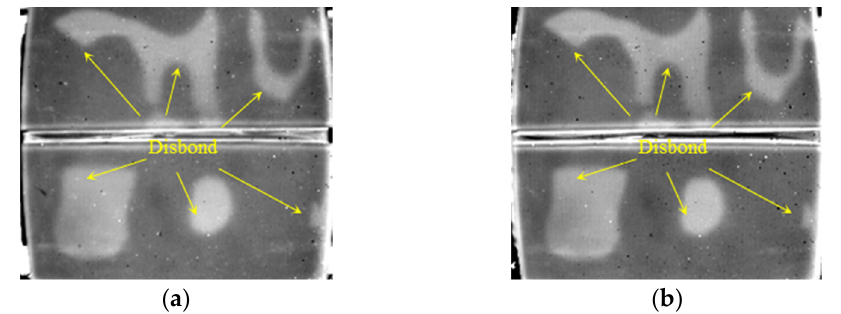
Figure 12. Detection results of disbond with 2 mm thick SIR. ( a ) The 829th frame 1st DTI. ( b ) The 1144th frame 2nd DTI.